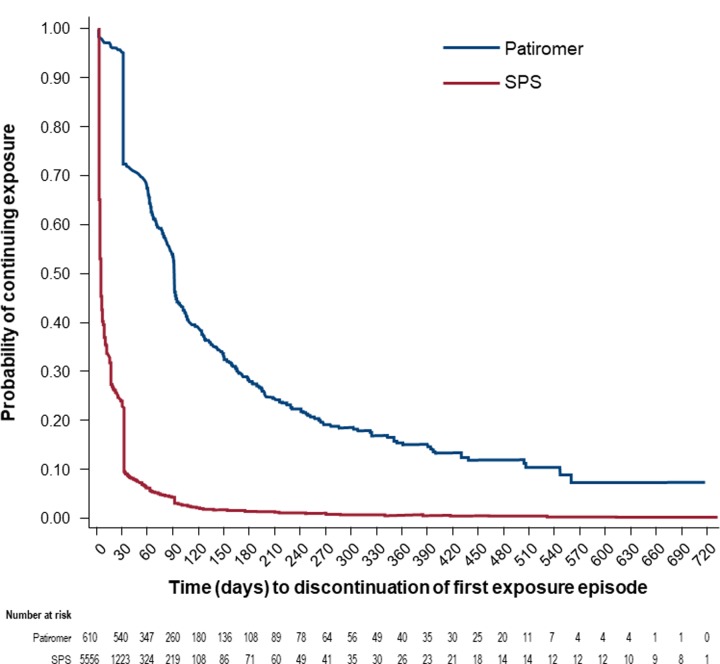
Duration of continuous K+ binder use (patiromer and SPS) to the first censoring event.Censoring events: index K+ binder discontinuation, opposing K+ binder dispensing, insurance disenrollment, end of study period (12/31/2017) Death. K+, potassium; SPS, sodium polystyrene sulfonate.